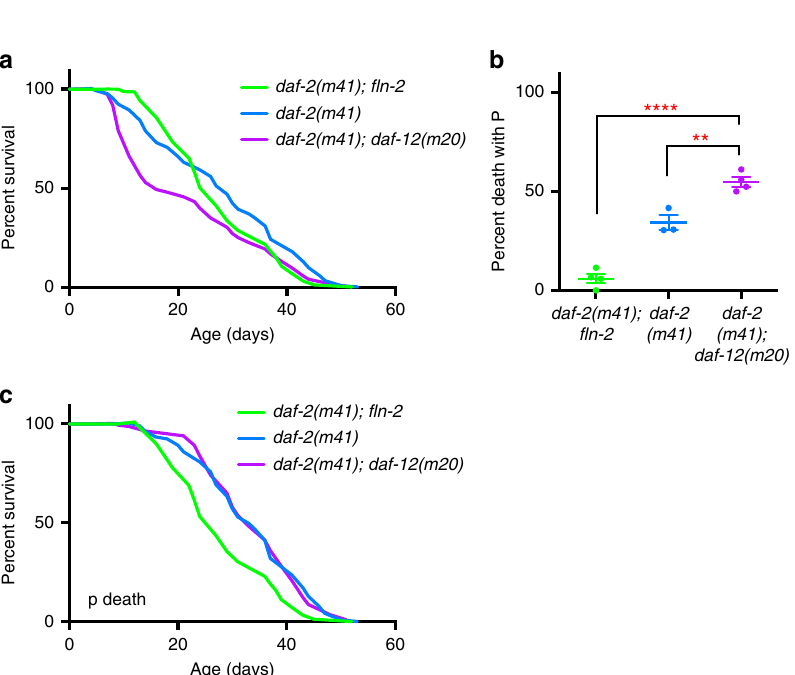
Fig. 4 Effect of daf-12 on daf-2 at 25 °C is partially affected by fl n-2(ot611) variation. a Lifespan and b necropsy analysis of daf-2(m41); daf-12(m20) and daf-2 (m41) mutants in fl n-2( + ) or fl n-2(ot611) backgrounds. daf-2 fl n-2 in green, daf-2 in blue, and daf-2 daf-12 in purple. Asterisks indicate signi fi cant differences, p < 0.0001 and 0.01, respectively. Error bars represent s.d. of two trials. See Supplementary Table 10 for full statistics, and Supplementary data 1 for raw mortality data. Source data are provided as a Source Data fi le. c Lack of lifespan effect by daf-12 in daf-2 p sub-population lifespan in fl n-2( + )